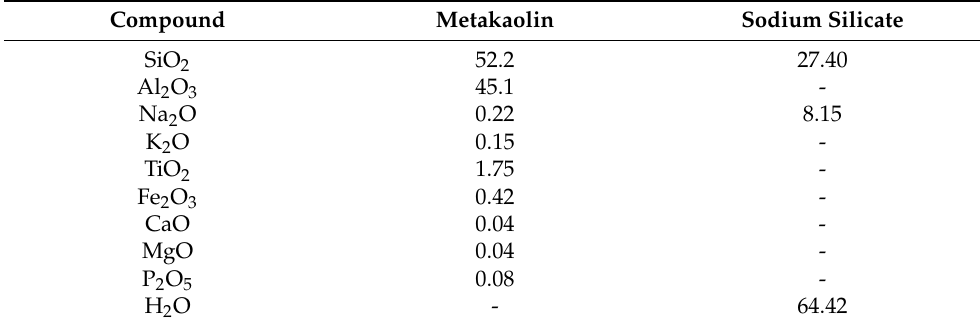
Table 1. Chemical composition (weight %) of the used metakaolin (BASF MetaMax ® ) and sodium silicate solution adapted from [17], MDPI 2022.